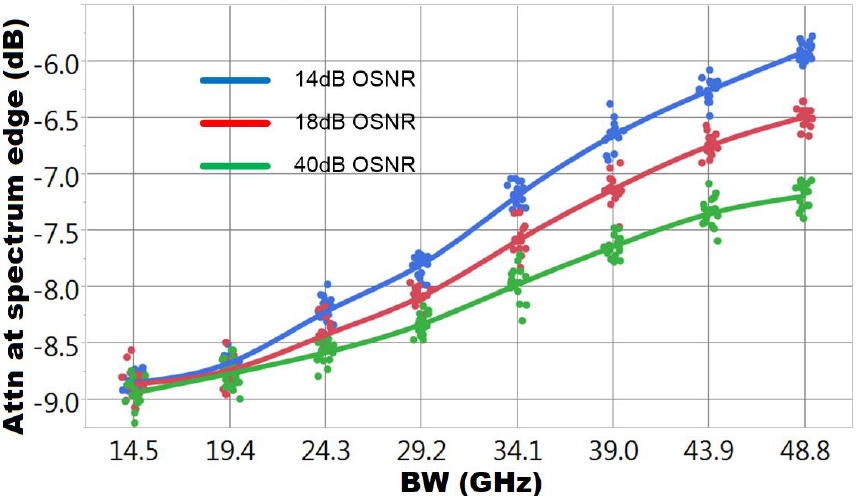
Figure 4. Attenuation at spectrum edge ( Attn Edge ) versus the signal’s bandwidth in the receiver. For each setting of signal’s bandwidth, we measure 16 times and take the average value.